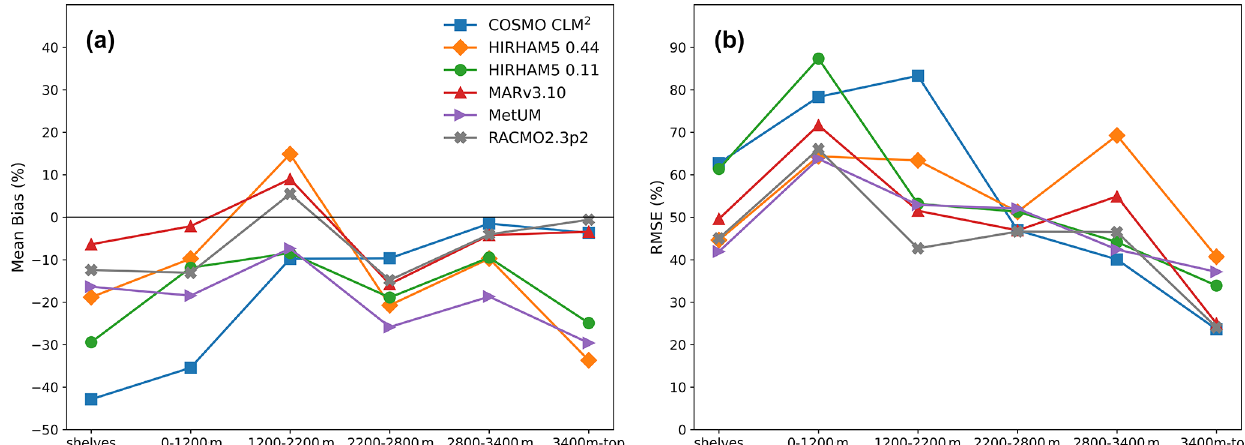
Figure A9. Mean bias and RMSE by elevation bin for each RCM compared to SMB observations as shown in Figs. 3 and 4.